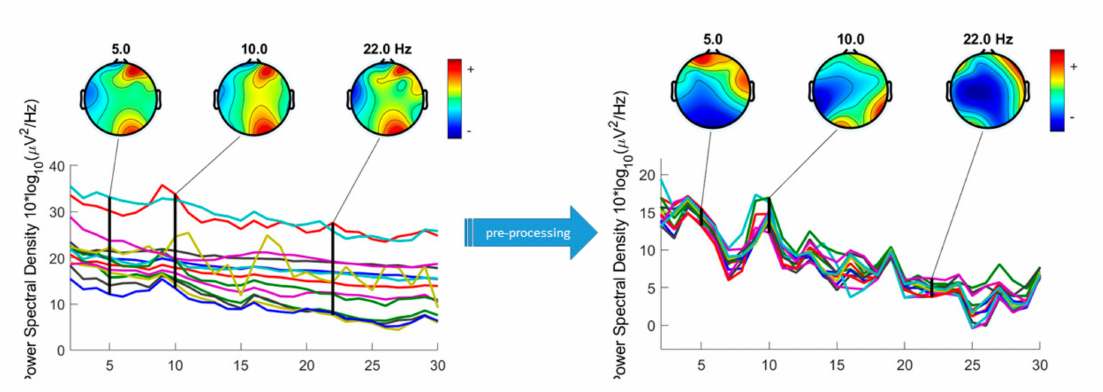
Figure 3. Pre- and Post-processed channels